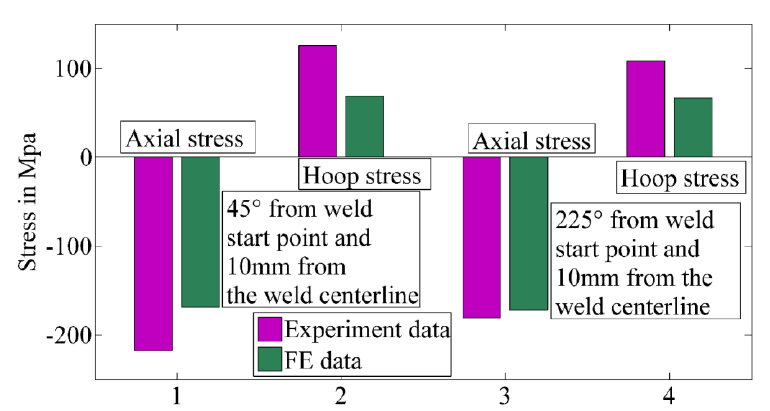
Fig. 6. Comparison of residual stresses obtained from analysis with experimental results on the outer surface, at two different sections.